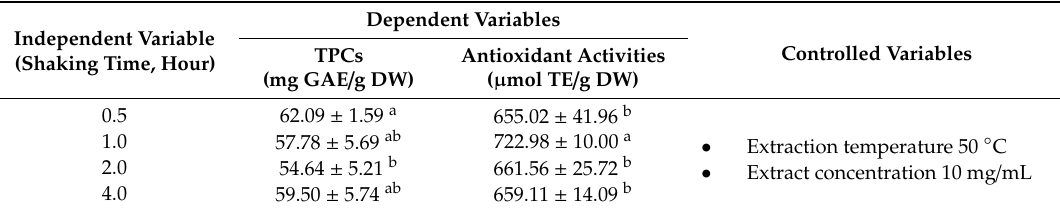
Table 2. E ff ects of di ff erent shaking times on sacred lotus stamen extraction regarding total phenolic contents (TPCs) and antioxidant activities determined by FRAP assay.